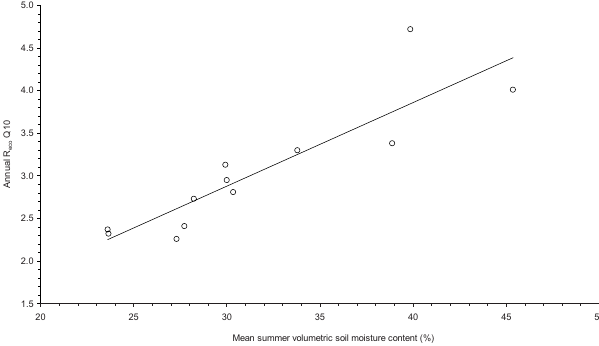
Fig. 11. Relationship between annual R eco Q10 and summer vol- umetric soil moisture content measured at a depth of 10cm at the Alice Holt Research Station ( r 2 = 0 . 78, p < 0 . 001). Annual Q10 values were calculated from the coefficients of an exponential func- tion fitted to monthly R eco and mean monthly air